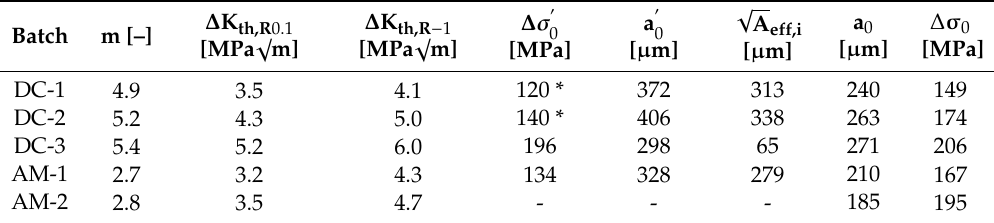
Table 5. Fatigue and crack propagation properties of die-cast (DC) and additively manufactured (AM) alloy AlSi7Mg0.3 and